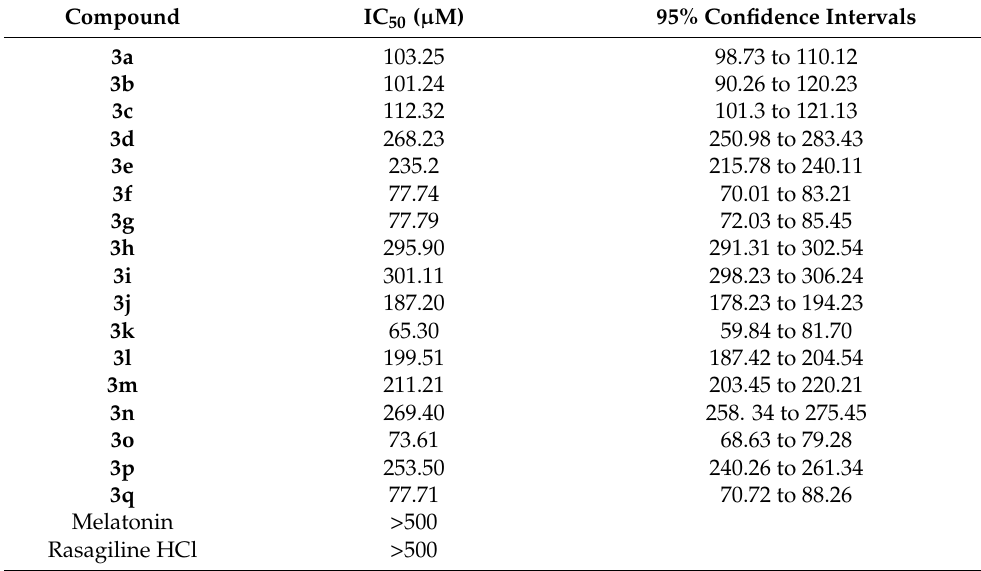
Table 1. In vitro cytotoxicity of the new benzimidazole derivatives (IC 50 values) on SH-SY5Y cells.